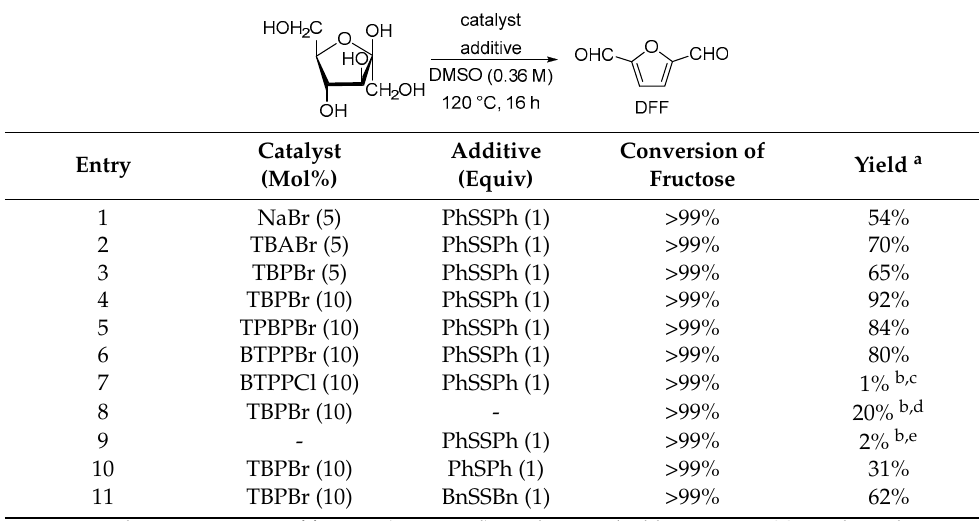
Table 1. Conversion of D-fructose to DFF.